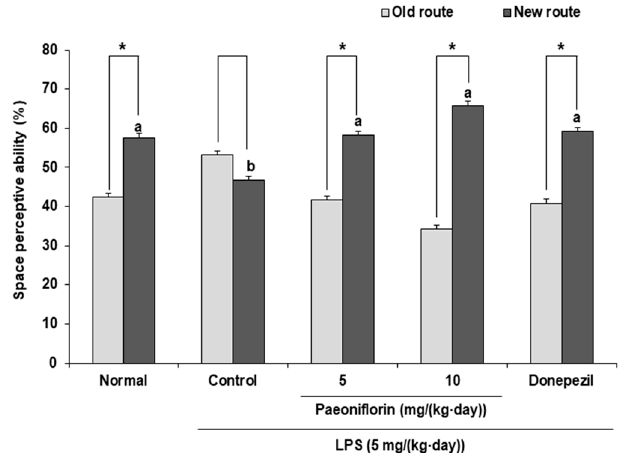
Figure 1. Effects of paeoniflorin on spatial perceptive ability by the T-maze test in LPS-injected mice. Data represent the mean ± SD. * p < 0.05 compared with the old route by a Student’s t -test. a,b Means with different letters are significantly different ( p < 0.05) by a Duncan’s multiple range test. Normal group = 0.9% NaCl i.p. ; Control group = LPS (5 mg/(kg ∙ day)) i.p. + 0.9% NaCl i.p. ; Paeoniflorin 5 group = LPS (5 mg/(kg ∙ day)) i.p. + paeoniflorin (5 mg/(kg ∙ day)) i.p. ; Paeoniflorin 10 group = LPS (5 mg/(kg ∙ day)) i.p. + paeoniflorin (10 mg/(kg ∙ day)) i.p. ; Donepezil group = LPS (5 mg/(kg ∙ day)) i.p. + donepezil (5 mg/(kg ∙ day)) i.p.